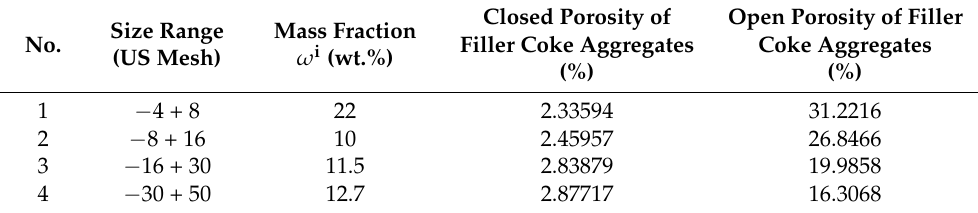
Table 4. Size and mass fraction of filler coke aggregates in anode paste sample